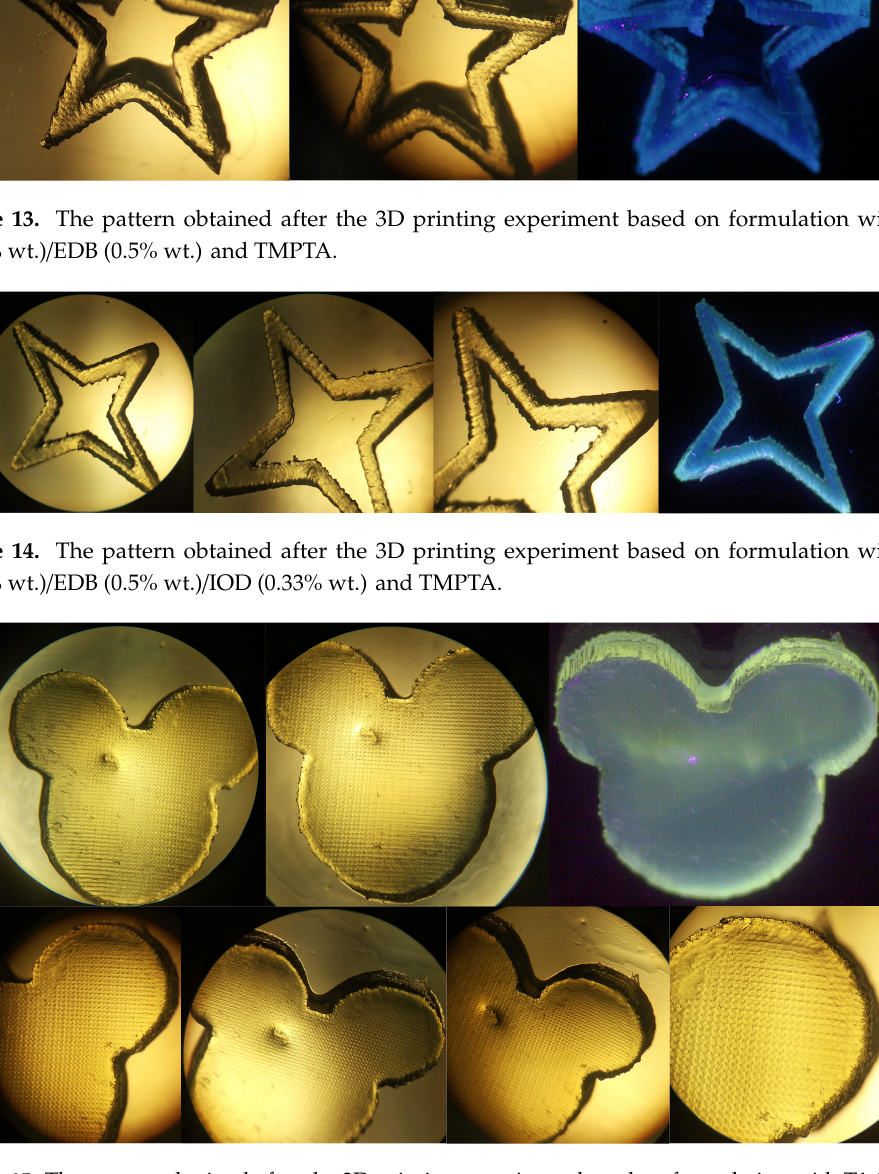
Figure 15. The pattern obtained after the 3D printing experiment based on formulation with T1 (0.07% wt.)/IOD (0.33% wt.) and TMPTA/UVACURE ® 1500 (1:1).